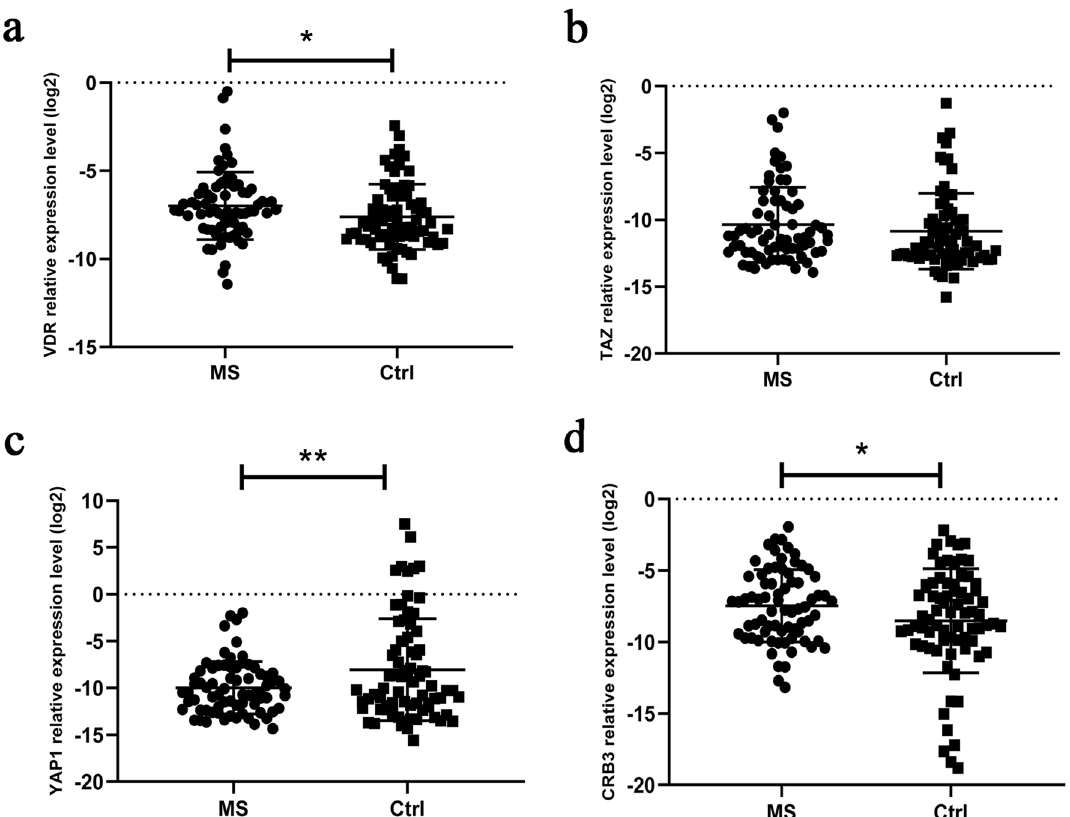
Figure 3. The relative expression level of ( a ) VDR , ( b ) TAZ , ( c ) YAP1 , and ( d ) CRB3 in all MS patients (n: 72) compared to healthy controls (n: 74). MS Multiple Sclerosis, Ctrl Control group. Whiskers represent the standard error of the mean. (*p < 0.05, **p < 0.01, ***p < 0.001).